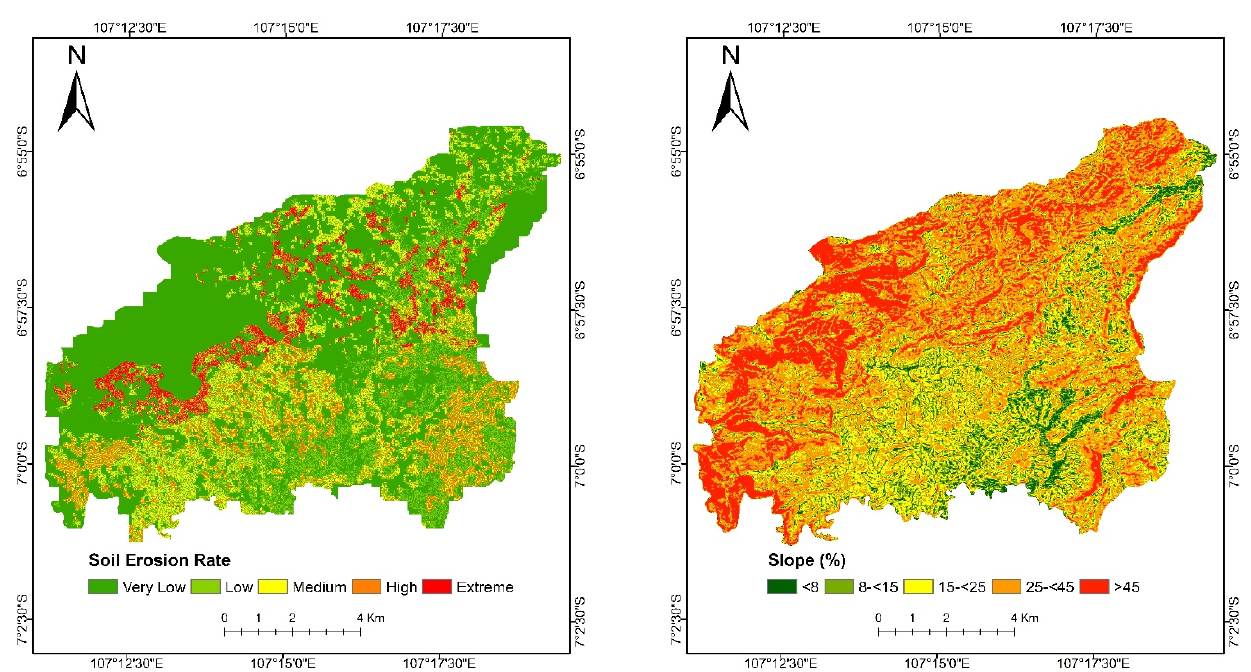
Figure 2. Soil erosion and slope distribution map in Rongga Sub-district.